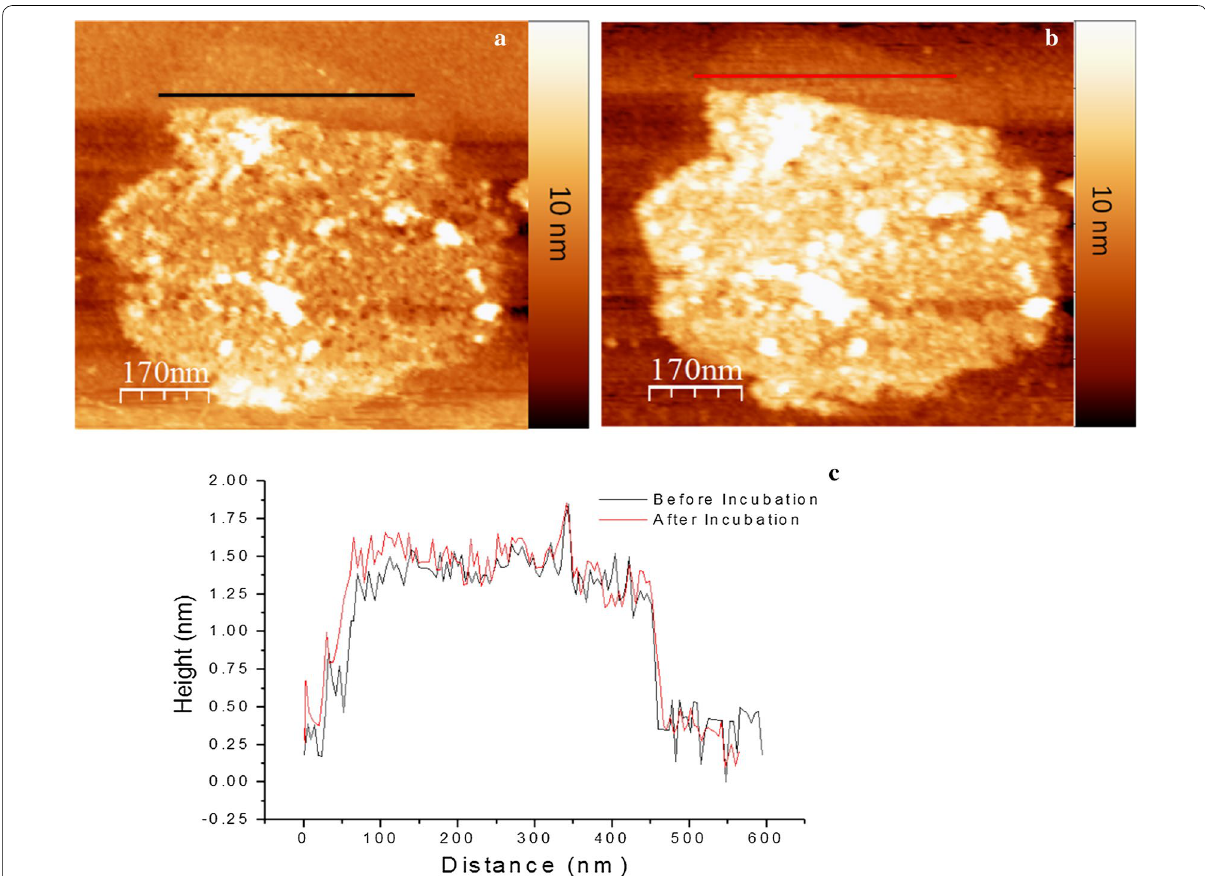
Fig. 6 CaM KI binding domain can bind immobilized CaM ( a ) inducing a conformational change ( b ). The height cross-sectional profiles of the same position on MUTMS patterned area in ( a ) and ( b ) were plotted in ( c